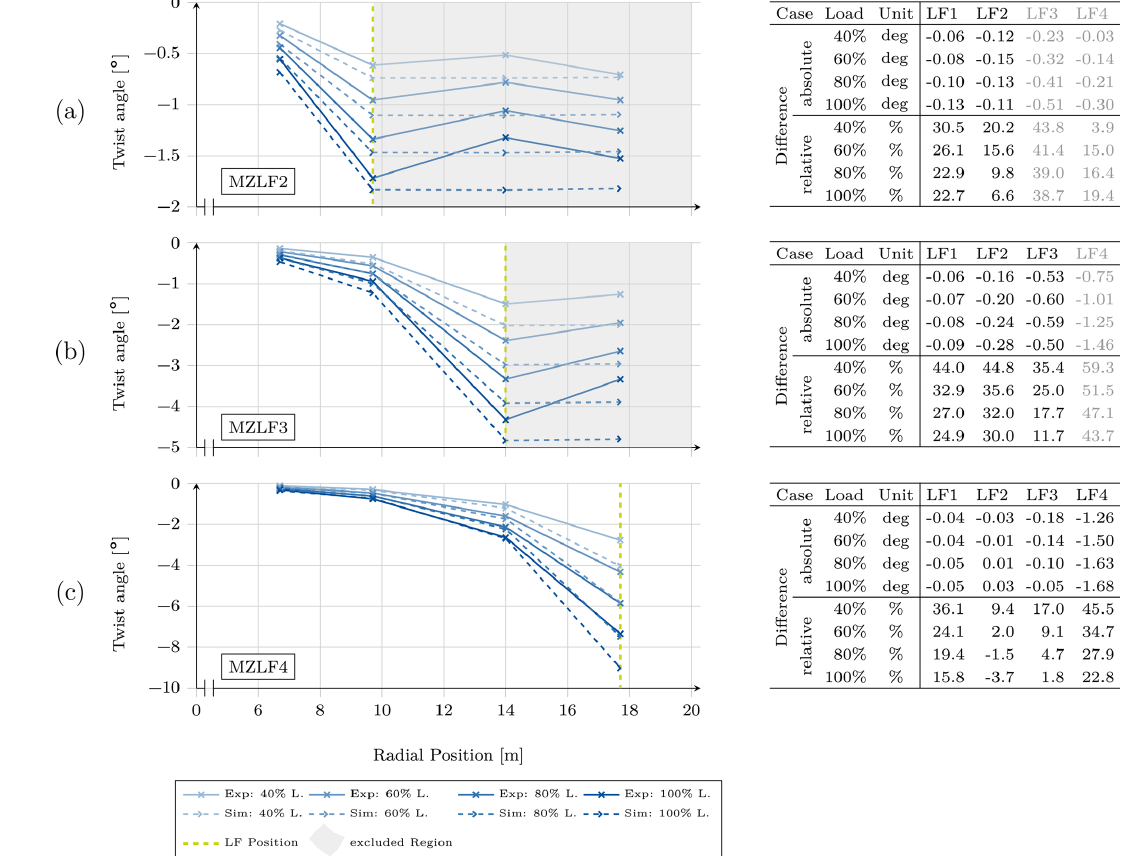
Figure 12. Twist angles calculated from the draw-wire sensor results for the (a) LF2, (b) LF3, and (c) LF4 torsional loading experiment and simulation. Results are shown for 40%, 60%, 80%, and 100% of the target load. The table on the right shows the differences between the simulation and the